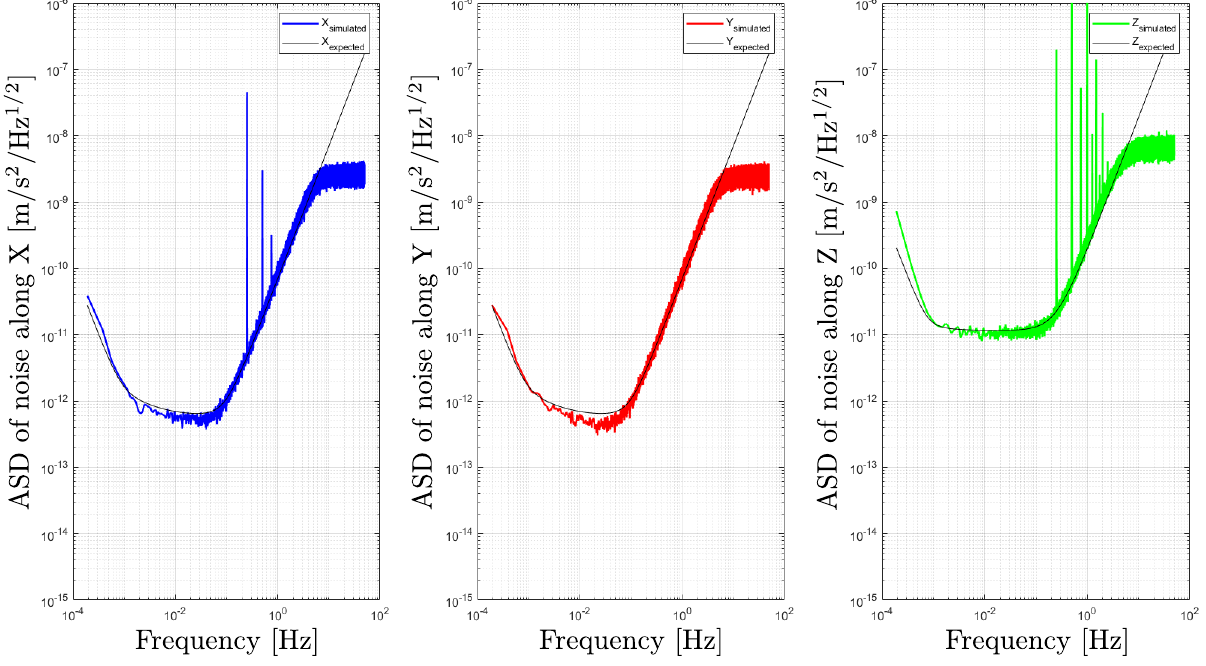
Figure 25. HybridSTAR accelerometer noise performance obtained with the hybrid instrument simulator. The EA’s proof-mass is rotated around the Y axis for satellite rotation compensation. The noise along the radial axis Z is slightly degraded due to this